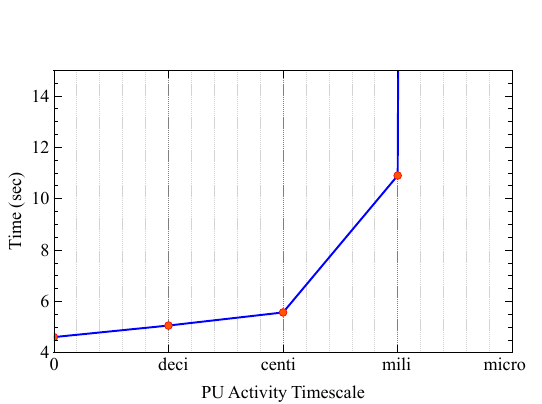
Figure 3. Throughput achieved over 2 GSM channels with varying time-scales of PU activity